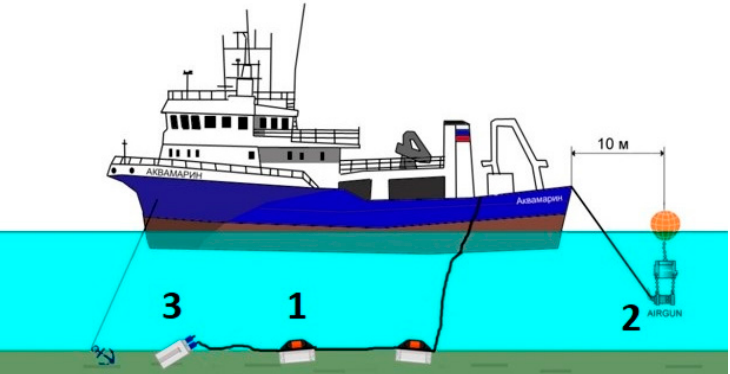
Figure 7. The scheme of the marine test. ( 1 ) hydrophones to compare; ( 2 ) single pneumatic source; ( 3 ) remote acquisition module.